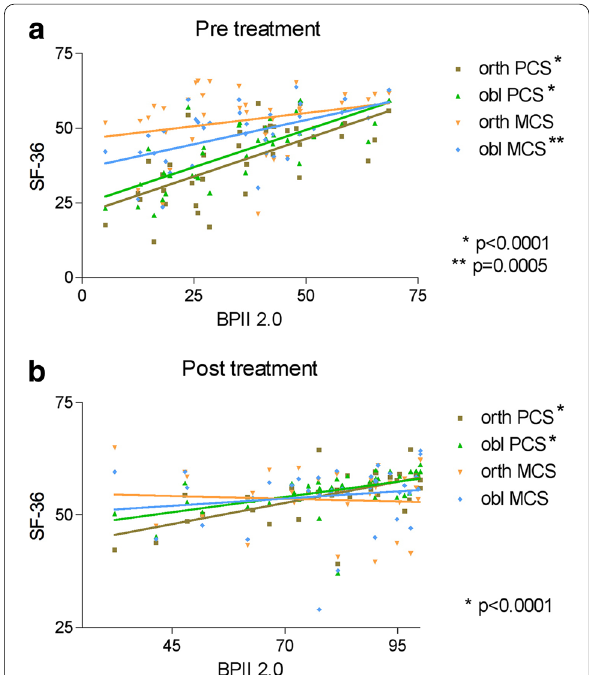
Fig. 2 a and b : Preoperative ( a ) and postoperative ( b ) correlations between PCS, MCS, and BPII 2.0 score values. PCS, physical component summary score; MCS, mental component summary score; obl, oblique; orth, orthogonal; BPII 2.0, Banff Patella Instablity Instrument